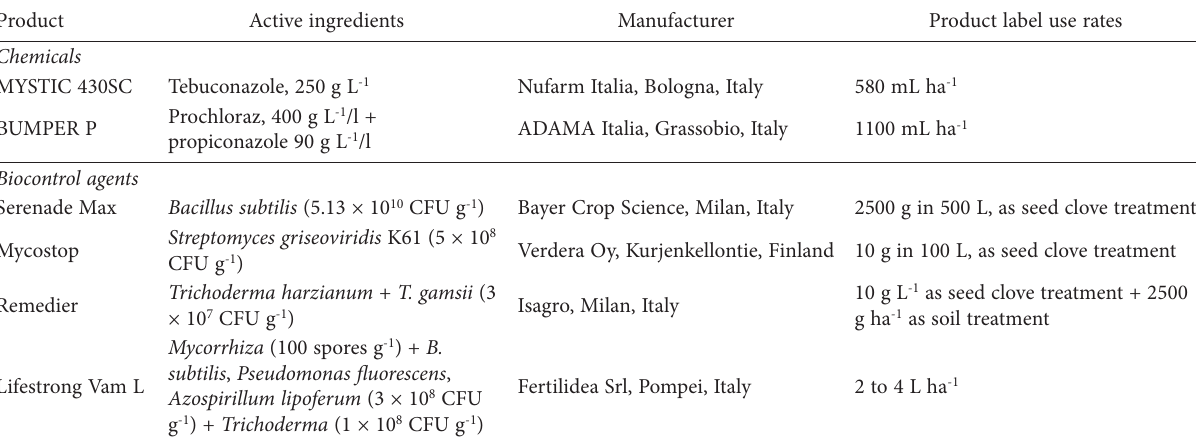
Table 1. Commercial plant protection products (chemicals or biocontrol agents) used in field trials.